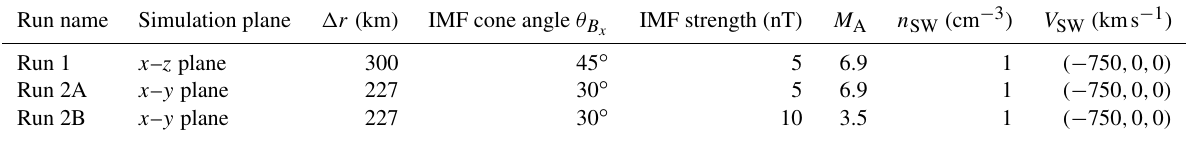
Table 1. Summary of the run parameters. Run